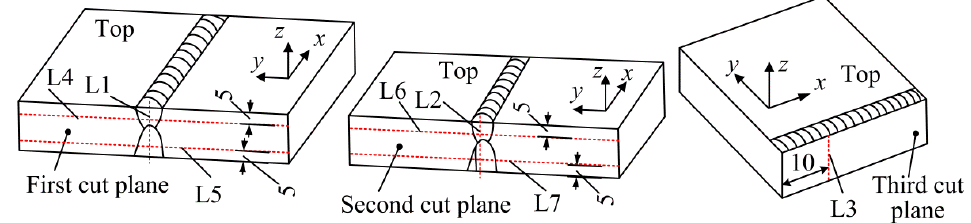
Figure 8. Schematic diagram of the locations of the stress evaluation lines.